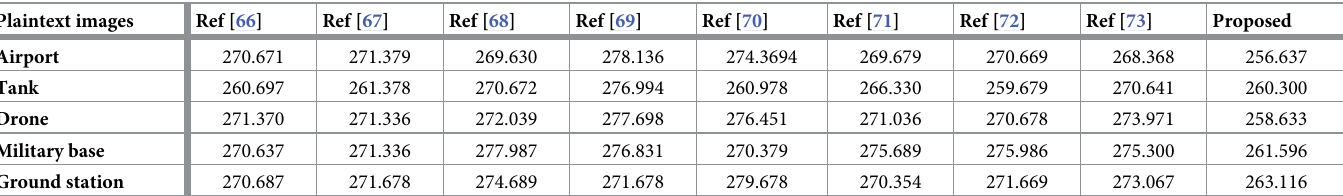
Table 3. Histogram variance analysis.